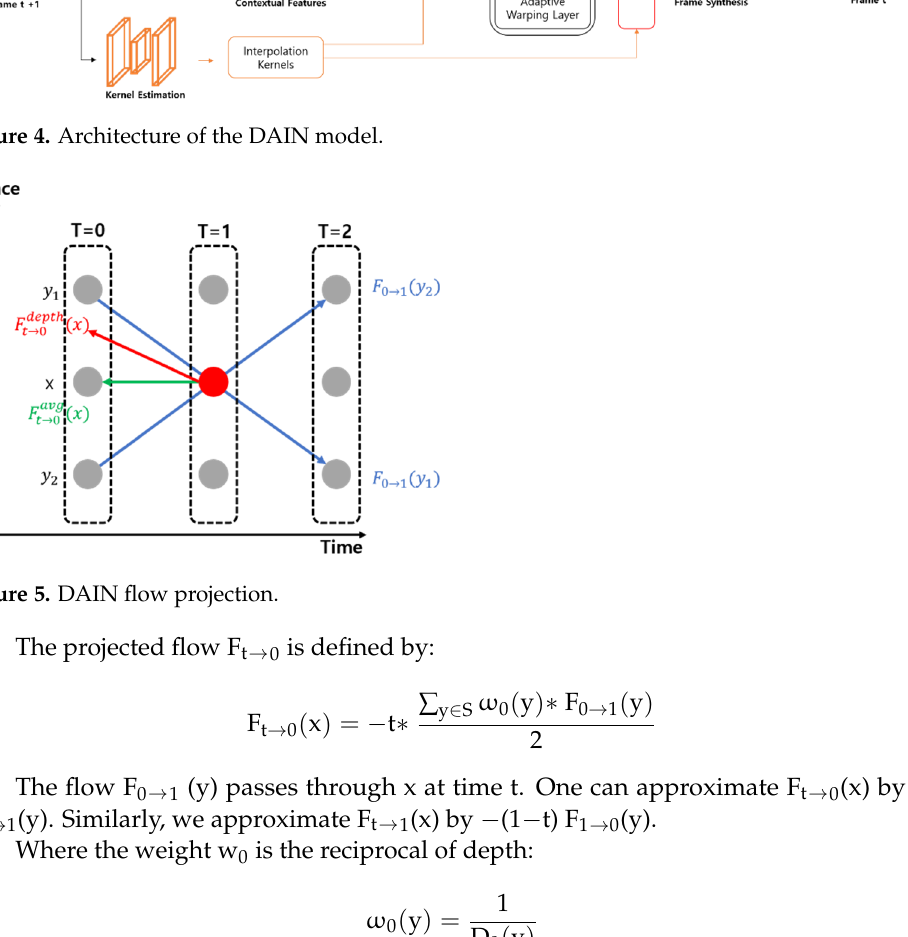
Figure 4. Architecture of the DAIN model.